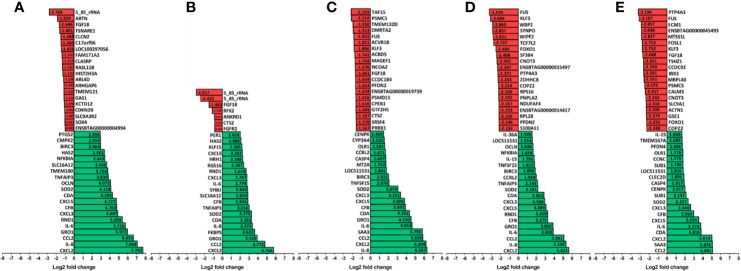
The 20 most upregulated and downregulated mRNA transcripts in bovine foot skin fibroblasts following challenge with pathogenic or commensal treponemes. Significantly dysregulated mRNA transcripts with the 20 most increased (green) and decreased (red) significant log2 fold changes (FDR-adjusted p value ≤0.05 and a log2 fold change ≥1 and ≤−1) in bovine foot skin fibroblasts challenged with (A) LPS from S. Typhimurium (control), (B)
T. medium phylogroup (strain T19), (C)
T. phagedenis phylogroup (strain T320A), (D)
T. pedis (strain T3552BT) or (E)
T. ruminis (strain Ru1T) are summarised. Data represents the mean differential mRNA transcript expression of three independent experimental replicates per challenge group (n = 3), with both T. phagedenis and T. ruminis represented by an additional technical replicate (n = 4). Log2 fold change values are provided within each bar for clarity and mRNA transcripts are given in abbreviated form against the corresponding bars.